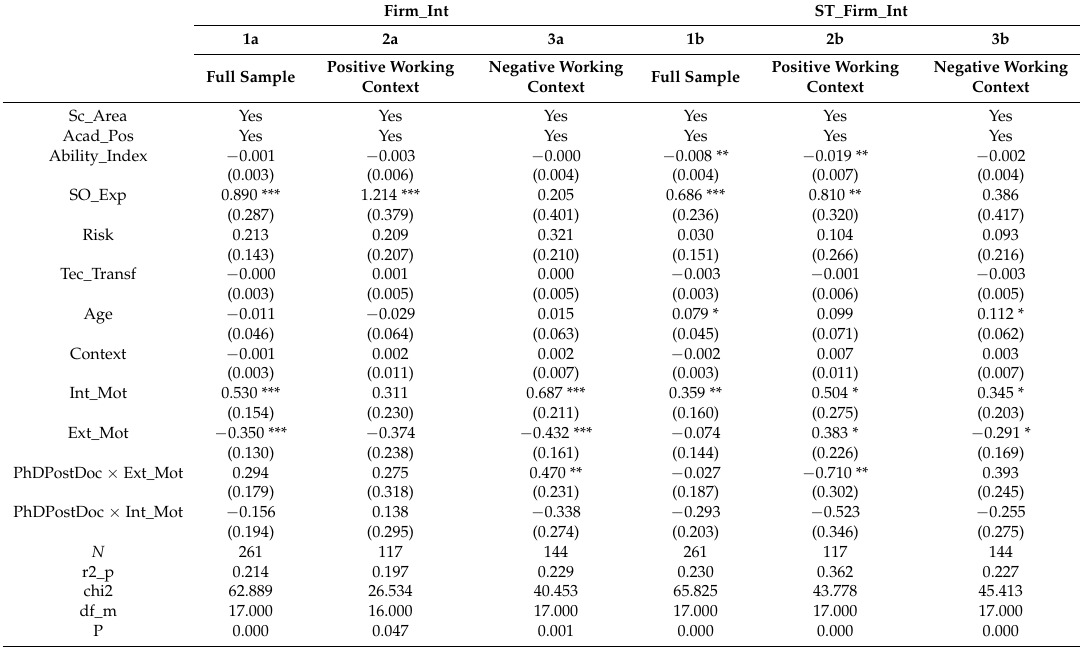
Table 9. Probit results (Marginal effects reported): Motivations interacted with PhDPostDoc .